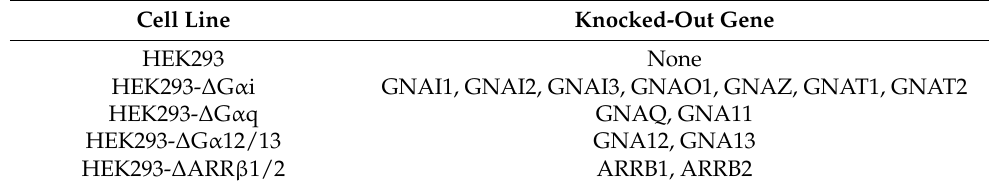
Table 3. Cell line overview and their respective gene